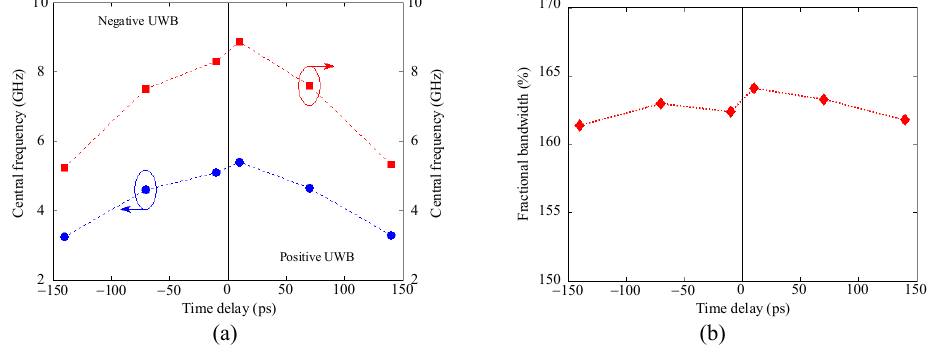
Fig. 6 Tunability in RF spectrum: (a) central frequency, 10-dB bandwidth and (b) fractional bandwidth as a function of the time delay. By synthesizing the results shown in Figs. 3, 4, 5, and 6, we find that when the time delay